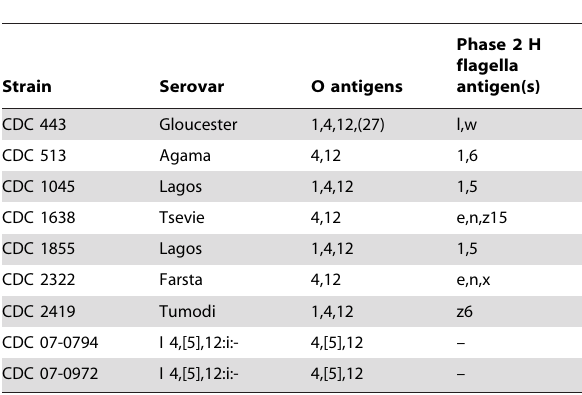
Table 1. Nine reference strains of Salmonella consisting of serovars that belong to O group B and that possess Phase 1 H flagella antigen ‘‘i’’.